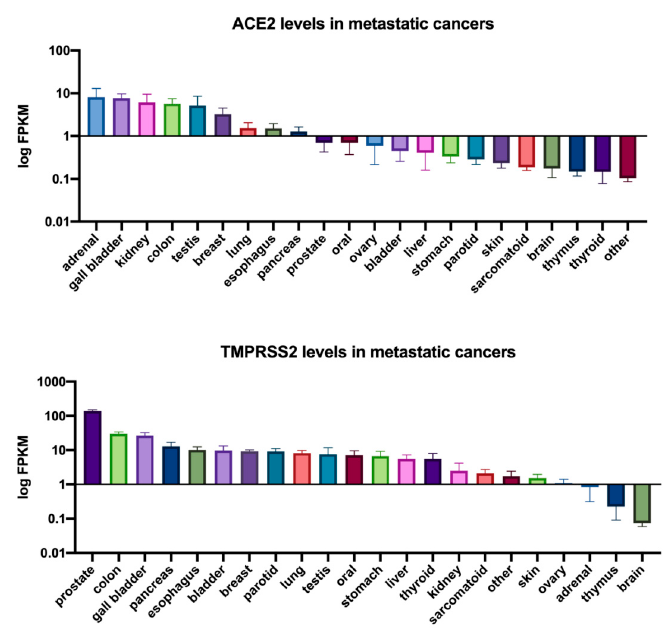
Figure 2. ACE2 and TMPRSS2 expression in metastatic cancers. ACE2 and TMPRSS2 FPKM expression values for metastatic cancers were obtained from the MET500 dataset [67] accessed through xenabrowser.net. The mean expression of ACE2 or TMPRSS2 for each tumor site is reported with the standard error of the mean (SEM). The results presented in Figure 2 were derived in part from data generated by The Cancer Genome Atlas (TCGA) research network. https://www.cancer.gov/tcga